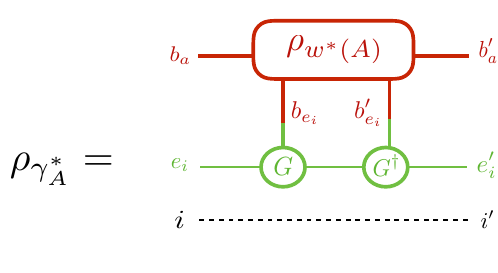
Figure 10. A state (cid:26) (cid:13) (cid:3) A that may be used to compute S A in our edge-mode code when X = ; . Every leg i cut by (cid:13) (cid:3) has an associated b e and e i , although only one such leg is drawn for A i